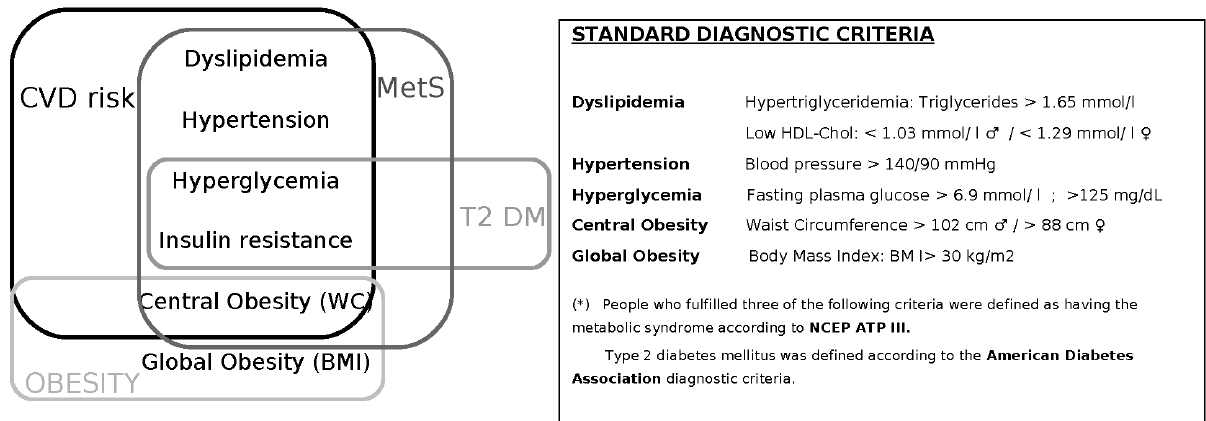
Figure 2. Diet-related Cardiodiabesity diagnostic parameters. Abbreviations are as follows: METS, metabolic syndrome; T2DM, type 2 diabetes mellitus; CVD, cardiovascular disease; WC, waist circumference; BMI, body mass